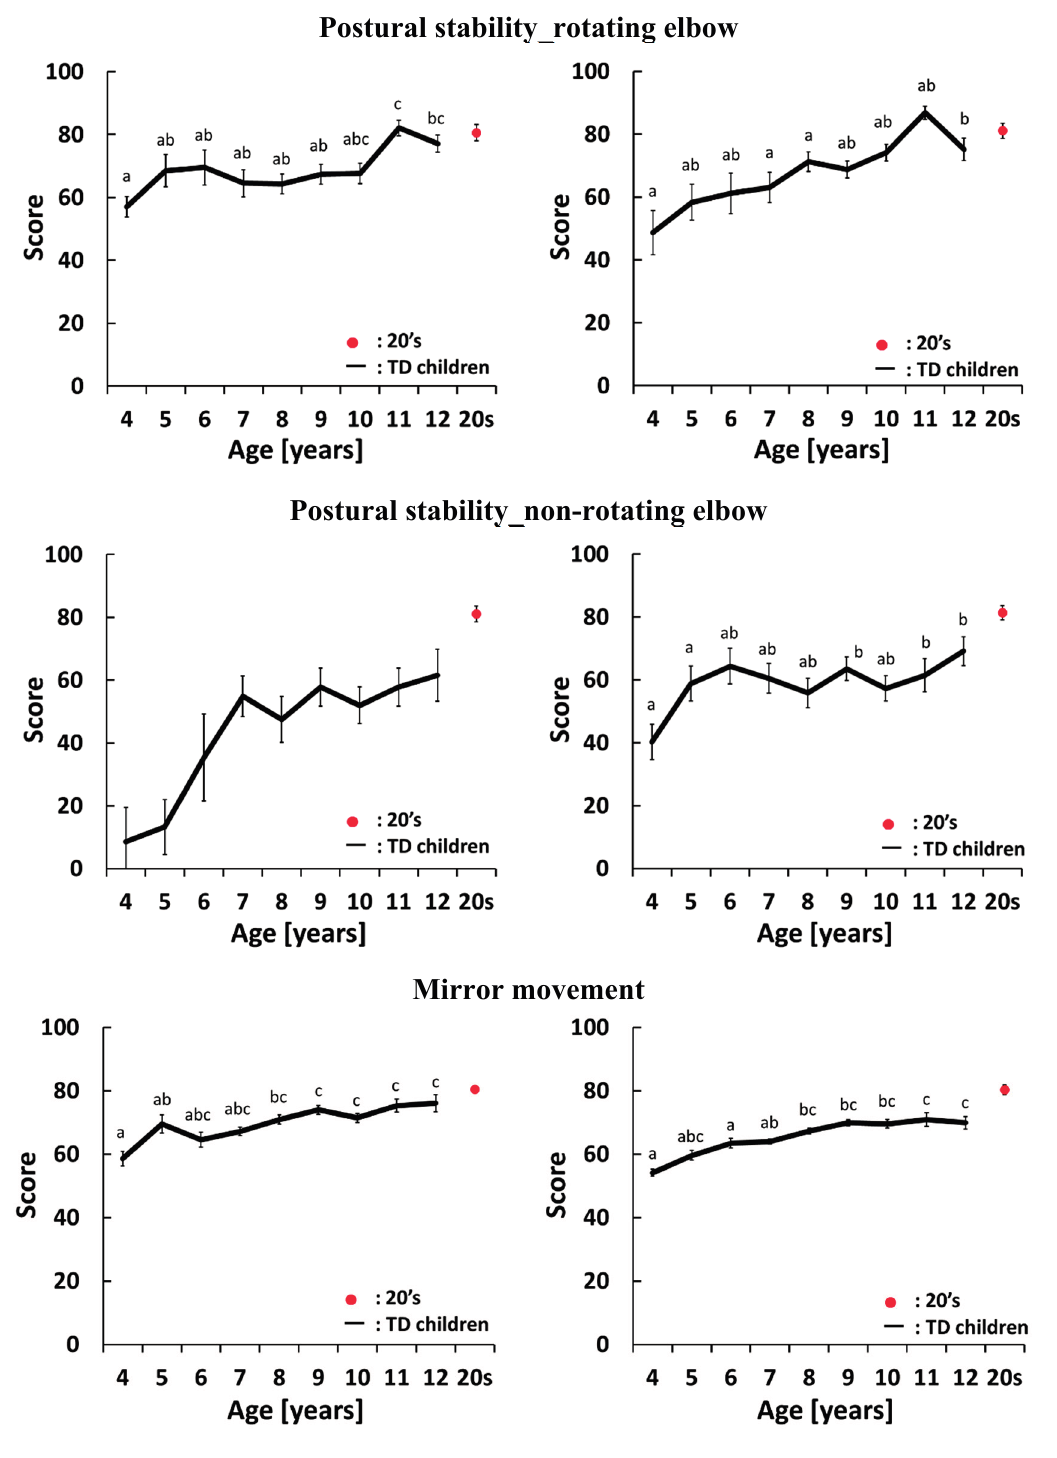
Figure 6. Average and standard error of scores in the maximal-effort motor task performed with one hand. The black line shows the average score for TD children. The red dot shows the average score for participants aged 21–26 years old. There is a significant difference between two different letters which do not include same alphabet on each standard error bars ( p <